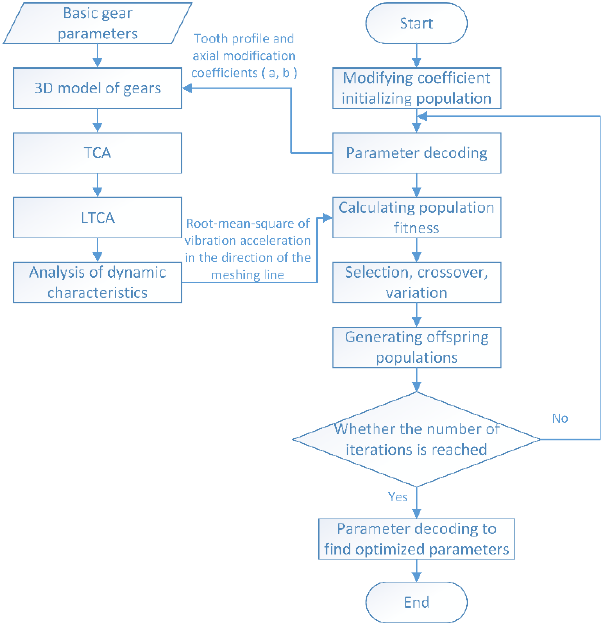
Figure 9. Genetic algorithm optimization process.